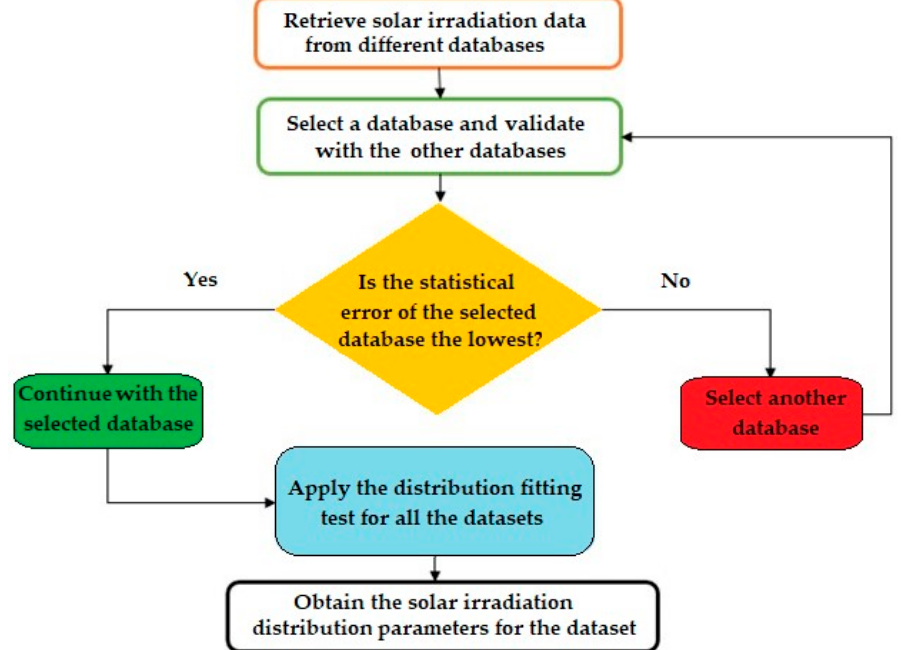
Figure 3. Flow chart of the proposed methodology. Source: own elaboration.